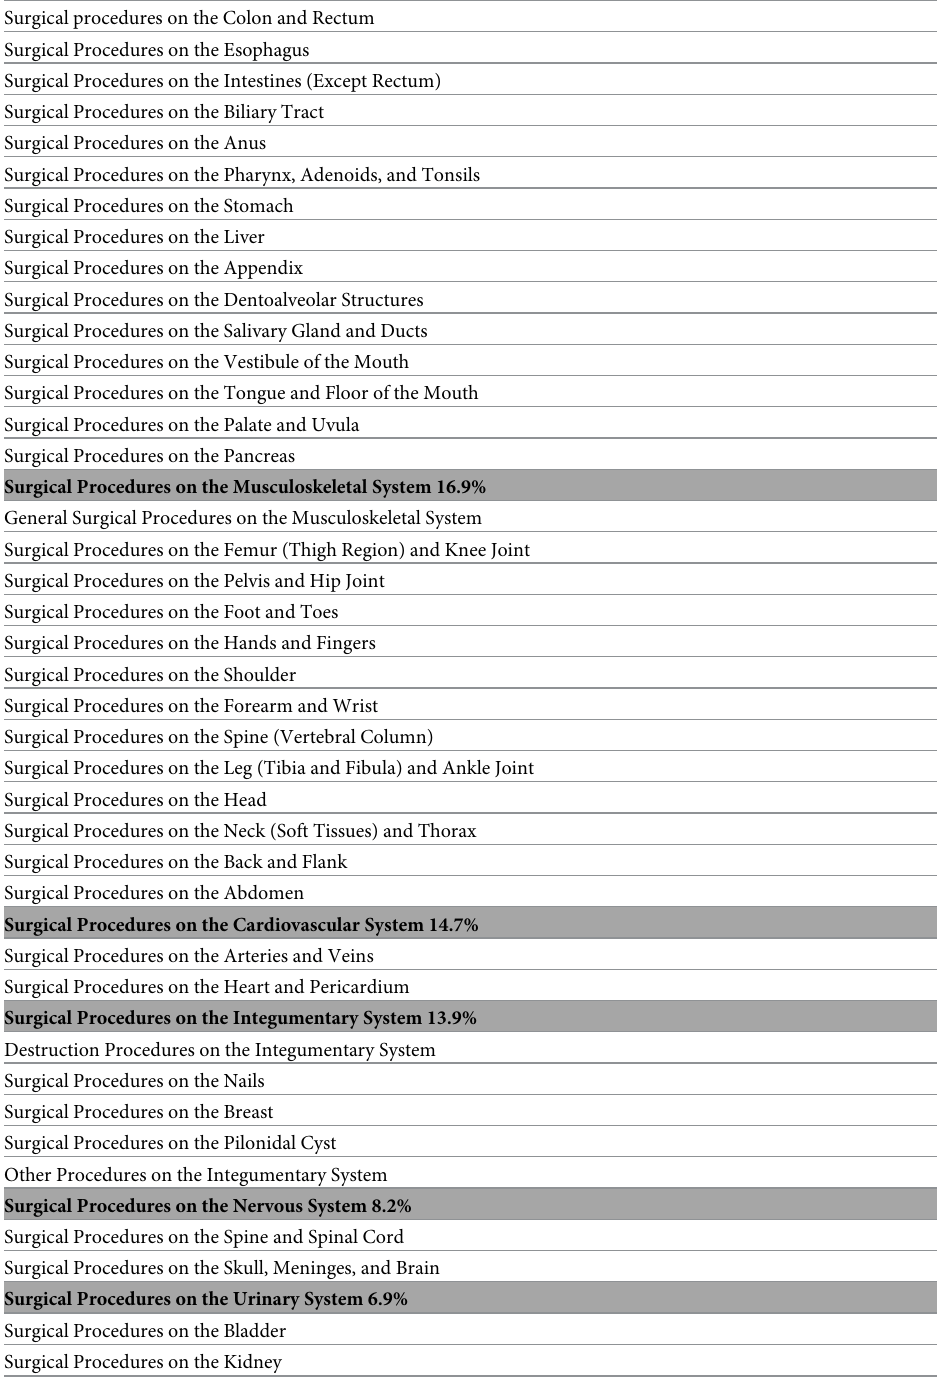
Table 1. Distribution of types of surgical procedures undergone by SARS-CoV-2-positive patients included in this analysis who had either received or not received pre-operative influenza vaccination. The distribution between the vaccinated and non-vaccinated cohorts was noted to be equal following propensity score matching and cohort